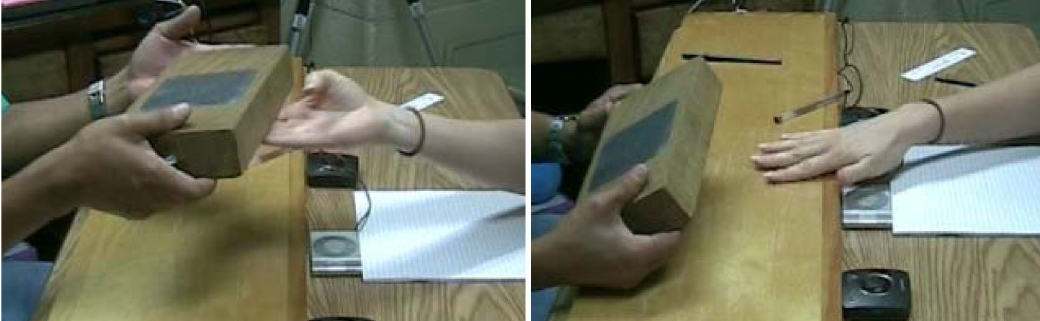
FIG. 1 (color online). Model-eliciting activity 1: Feeling of rough and smooth wooden surfaces.